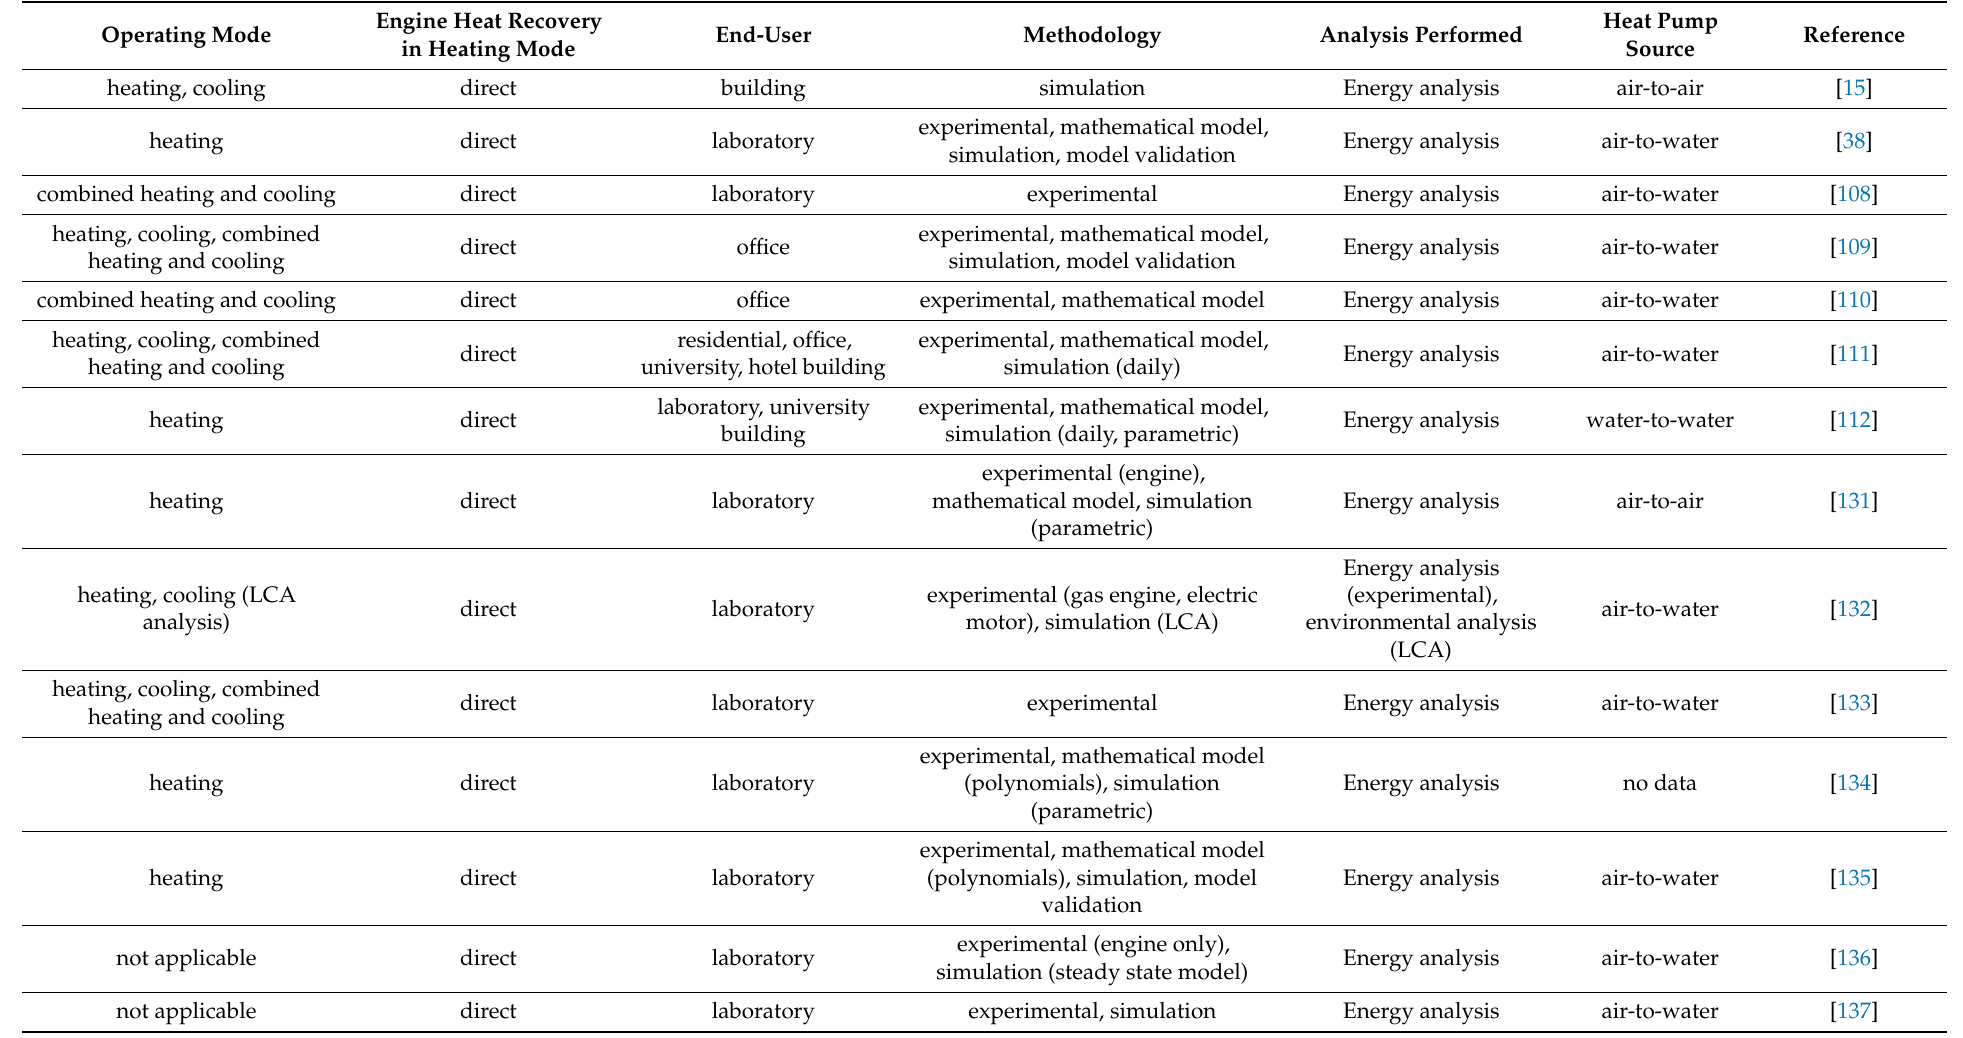
Table A5. Summary table for GEHPs with generator analysed in the